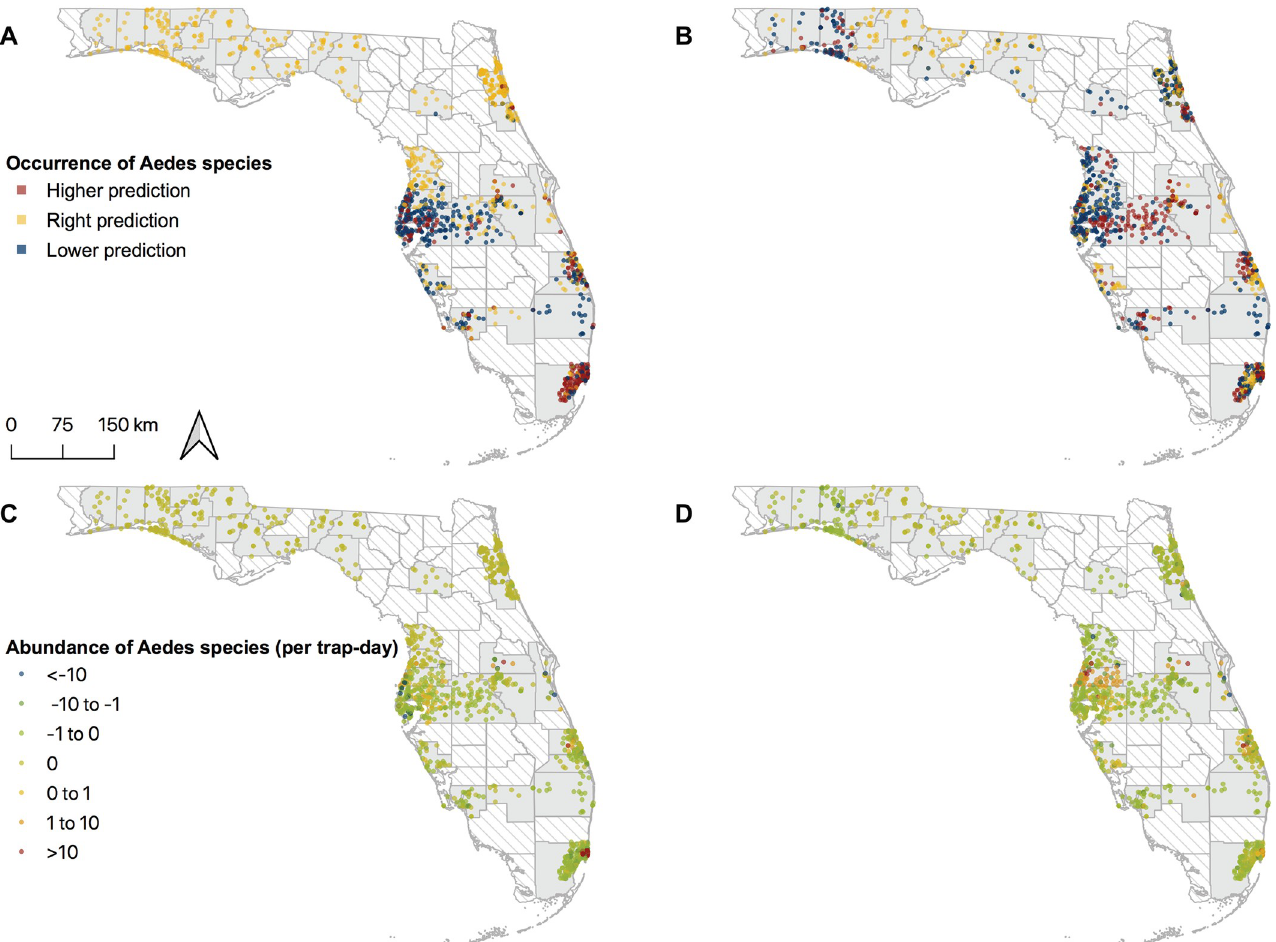
Fig 2. Geographic variations in model predictions in occurrence and abundance of Aedes aegypti and Aedes albopictus . (A) Differences in occurrence of Ae . aegypti . (B) Differences in occurrence of Ae . albopictus . (C) Differences in abundance of Ae . aegypti . (D) Differences in abundance of Ae . albopictus . Each trap site may have multiple predictions from different time points, so values presented here are the mean differences between predictions and observations for each trap site. Maps produced using QGIS Version 3.0.2 (QGIS Development Team, 2018). Source of shapefile: Southwest Florida Water Management District